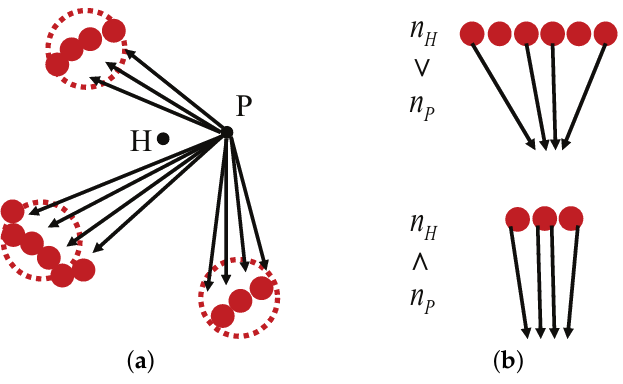
Figure 5. Landmark vector matching in the C-DELV method ( a ) landmark vectors at a position P ; ( b ) vector matching example with n p = 4 (top: n h > n p , bottom: n h < n p